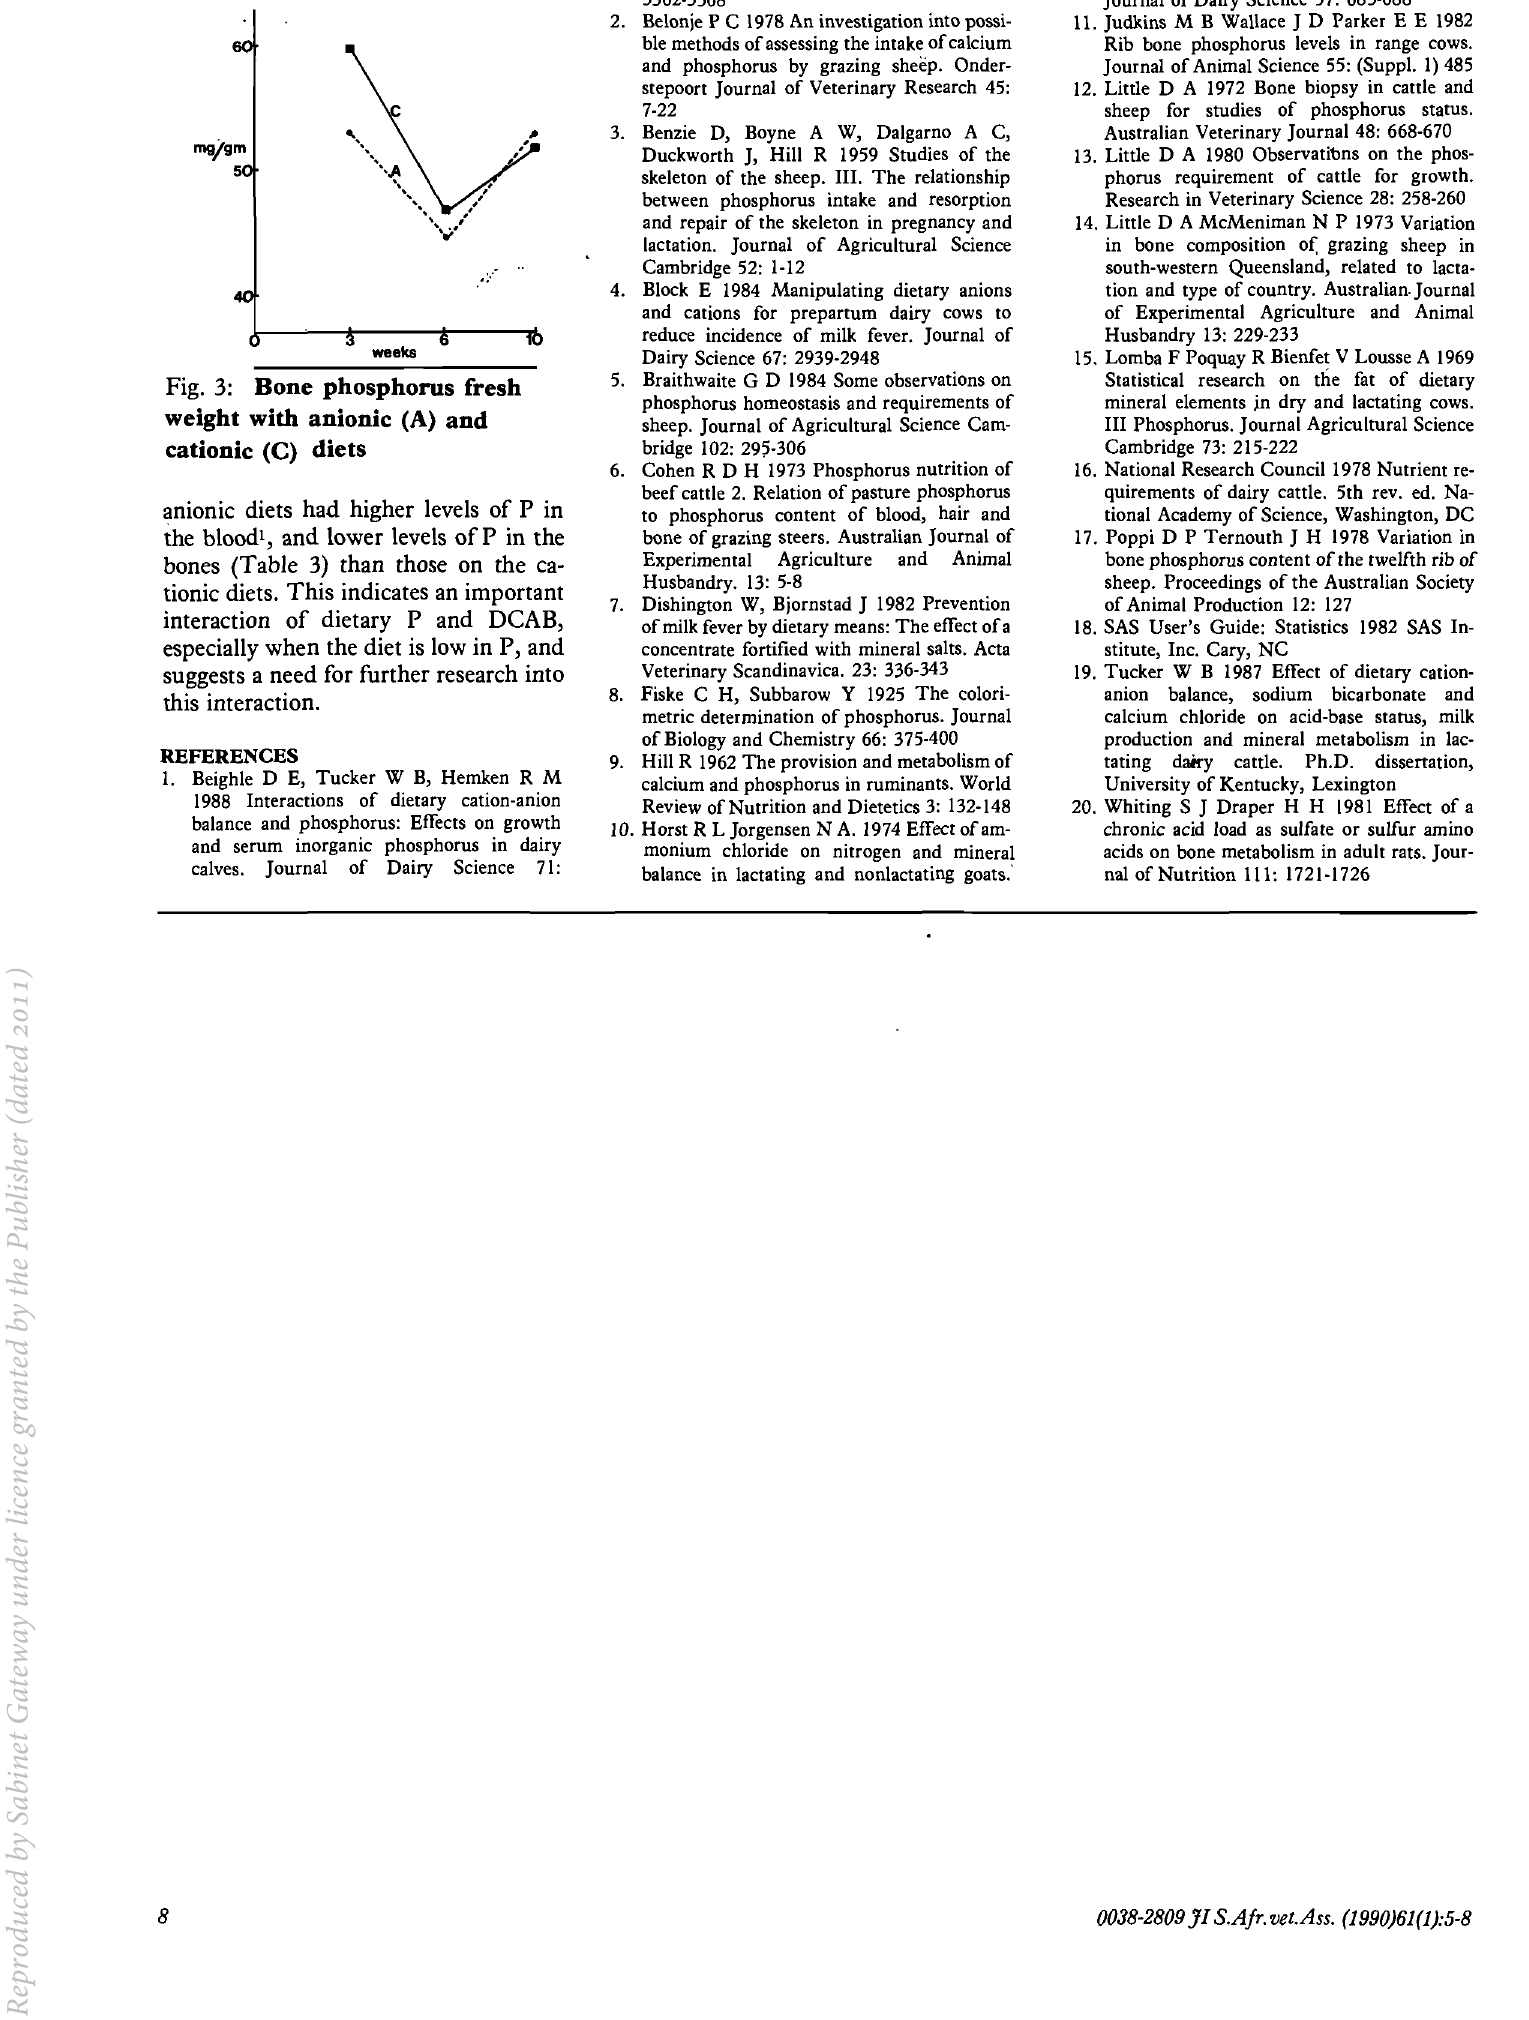
balance and phosphorus: Effects on growth and serum inorganic phosphorus in dairy calves. Journal of Dairy Science